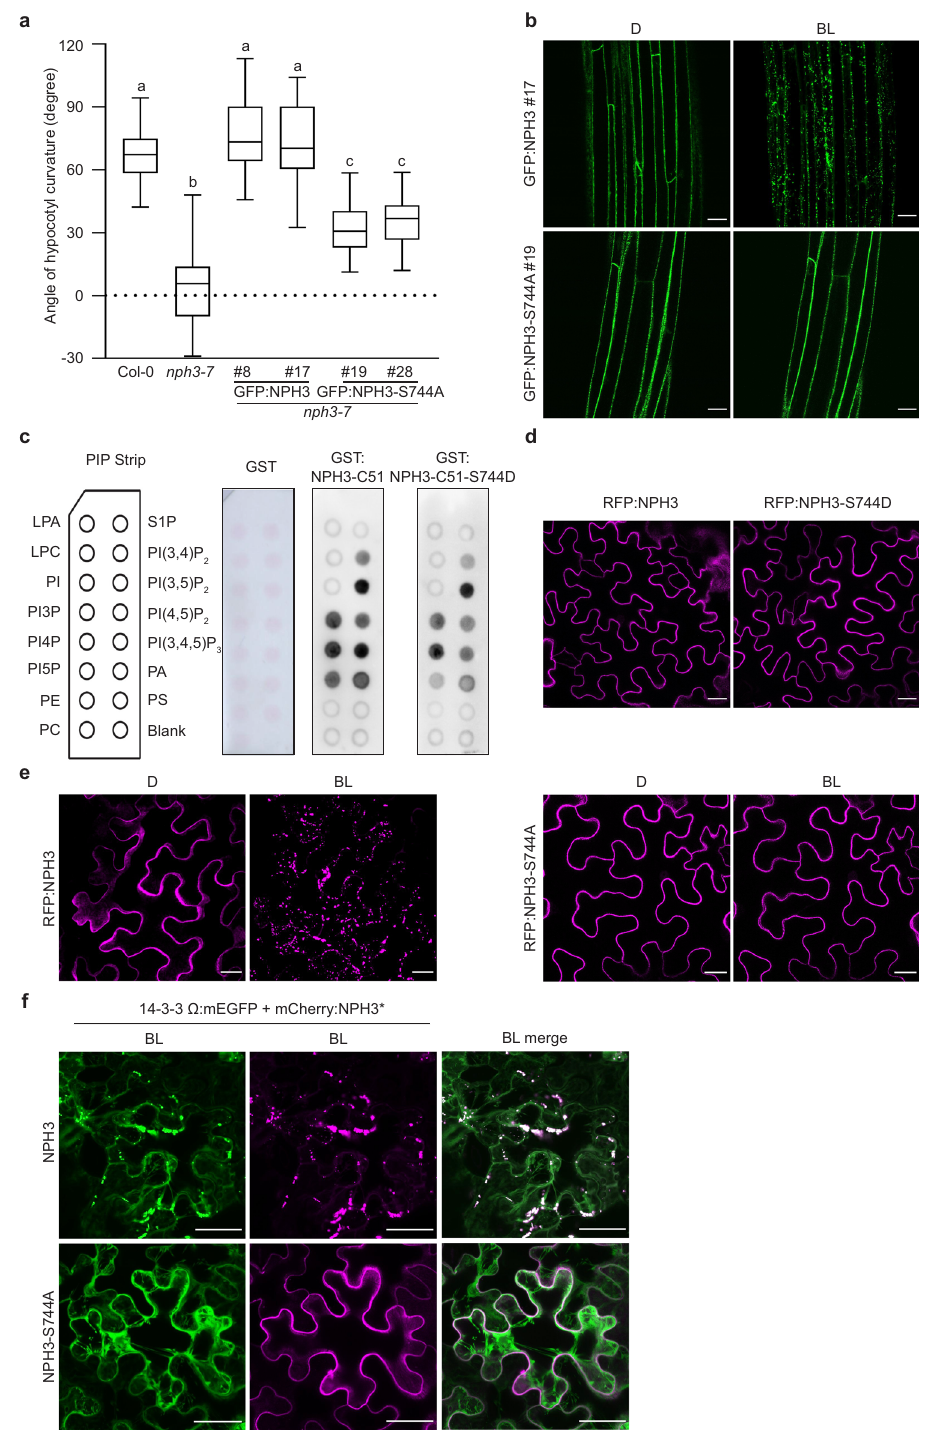
might per se decrease the interaction of NPH3 with polyacidic phospholipids, hence triggering the PM dissociation. Yet, the appropriate phosphomimic version of NPH3 (S744D) was neither impaired in phospholipid interaction in vitro (GST:NPH3-C51-S744D, Fig. 4c) nor PM recruitment in vivo (RFP:NPH3-S744D, Fig. 4d). Altogether, the C-terminal domain serves a dual function in determining the subcellular localization of NPH3, as it comprises both the amphipathic helix required for phospholipid-dependent PM association